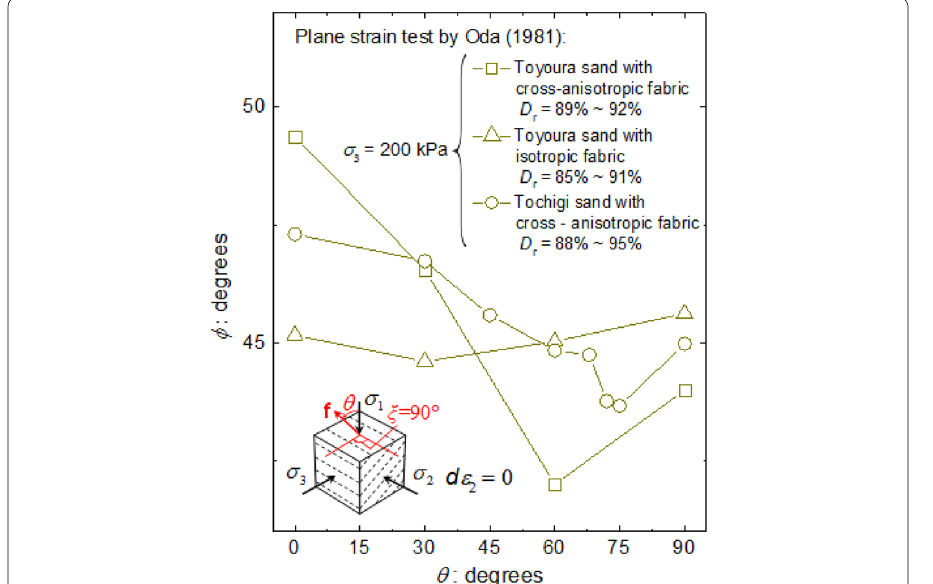
Fig. 5 Anisotropic strength of cross-anisotropic Toyoura sand, isotropic Toyoura sand, and cross-anisotropic Tochigi sand in plane strain compression